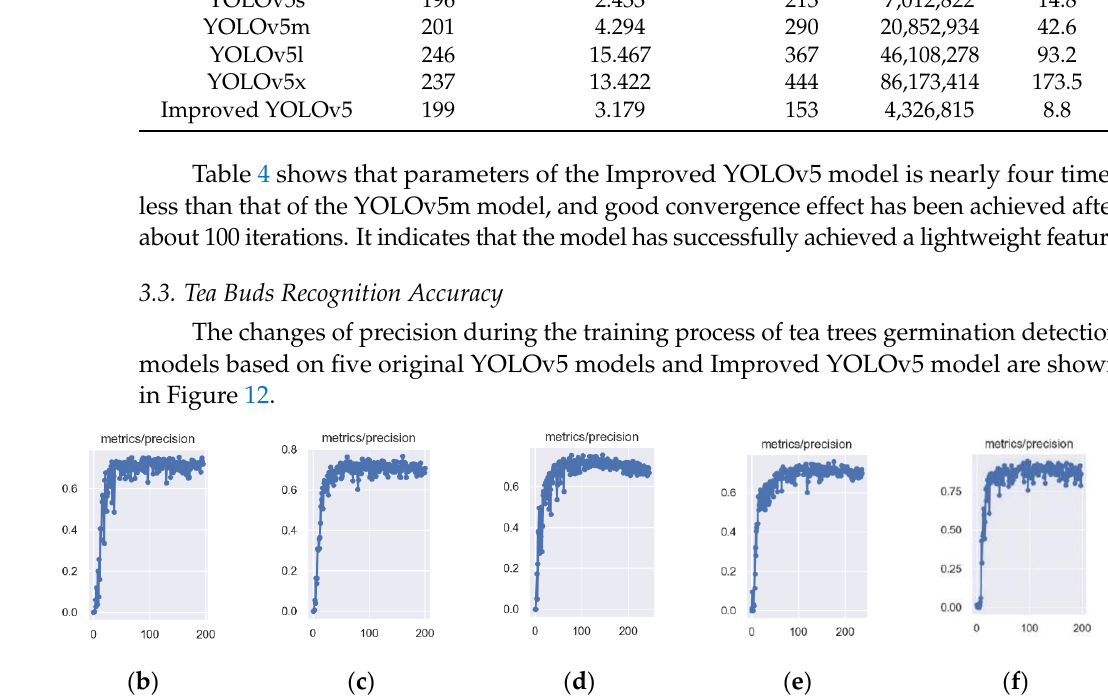
Table 4. Training information of different YOLOv5 models.